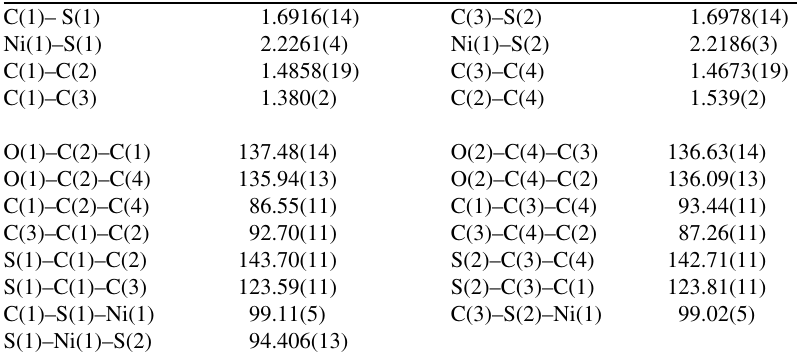
[ Ni(dtsq) ] P) 3 2 2